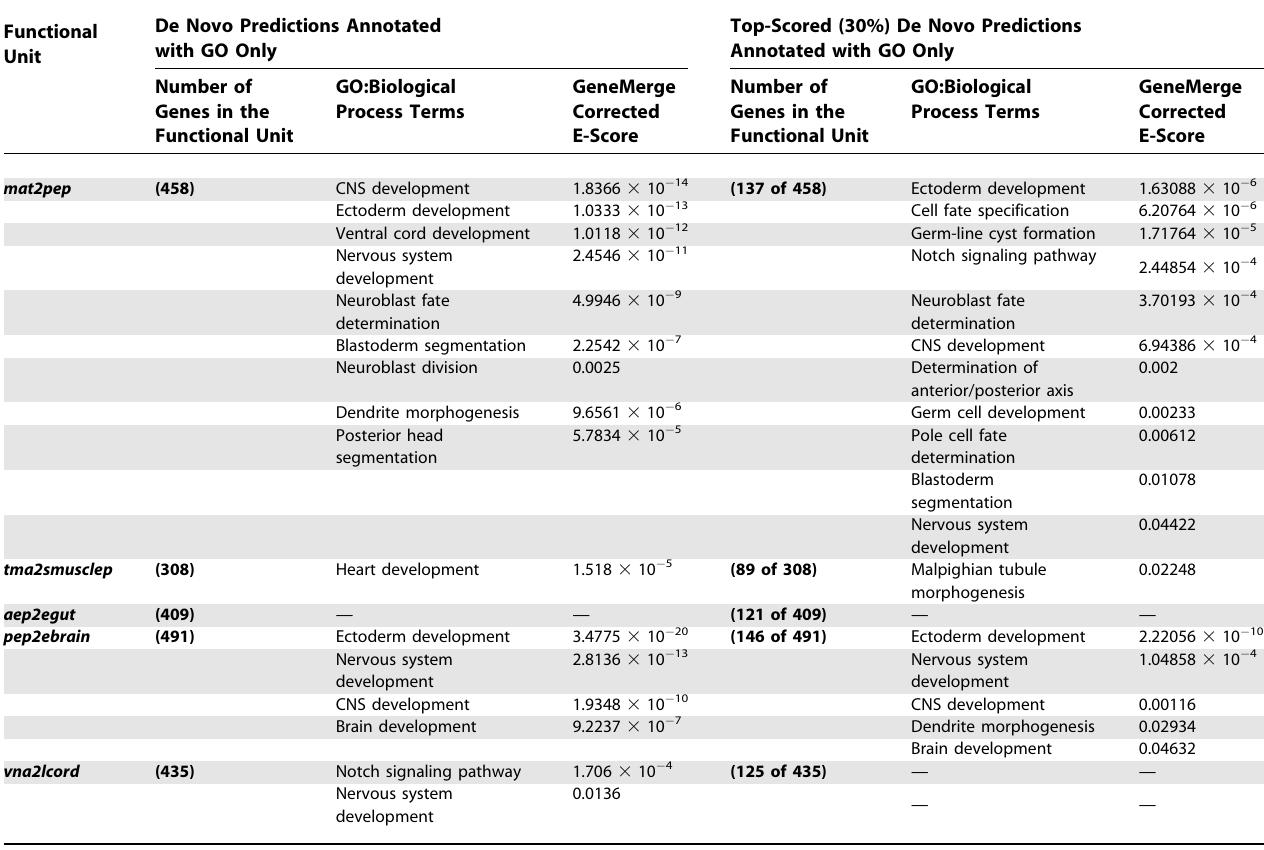
Numbers in parentheses represent de novo predictions confirmed with GO terms (heights of blue bars, see Figure 3). —, no overrepresented GO terms